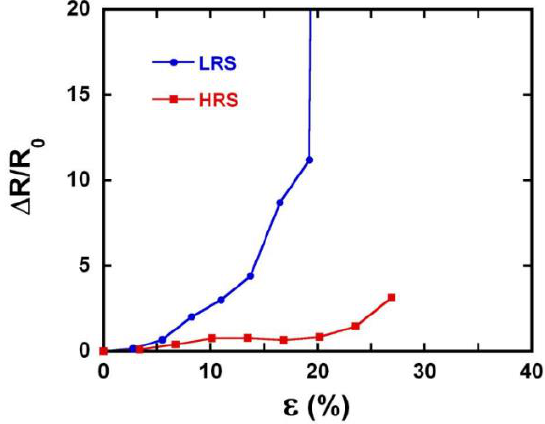
Figure 6. HRS current characteristics for the NT resistive memory under applied different ε values.